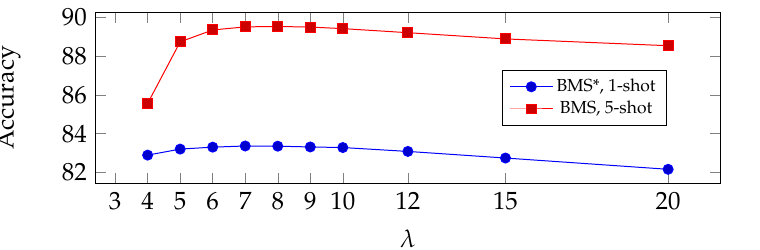
Figure 5. Accuracy of the proposed method on miniImageNet (backbone: WRN) as a function of training epoch e ( top ) and regulation parameter λ ( bottom ).